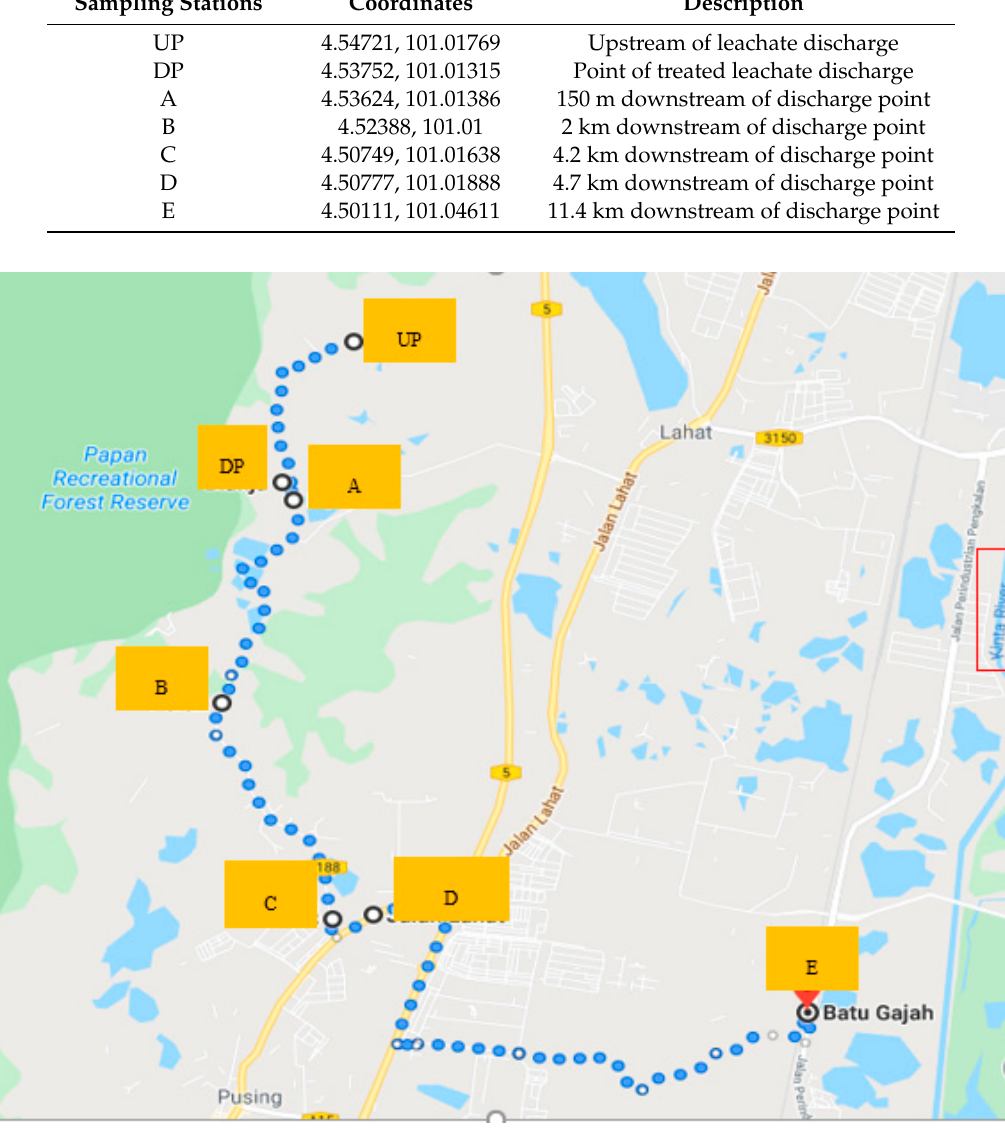
Figure 2. Sampling stations along Johan River.